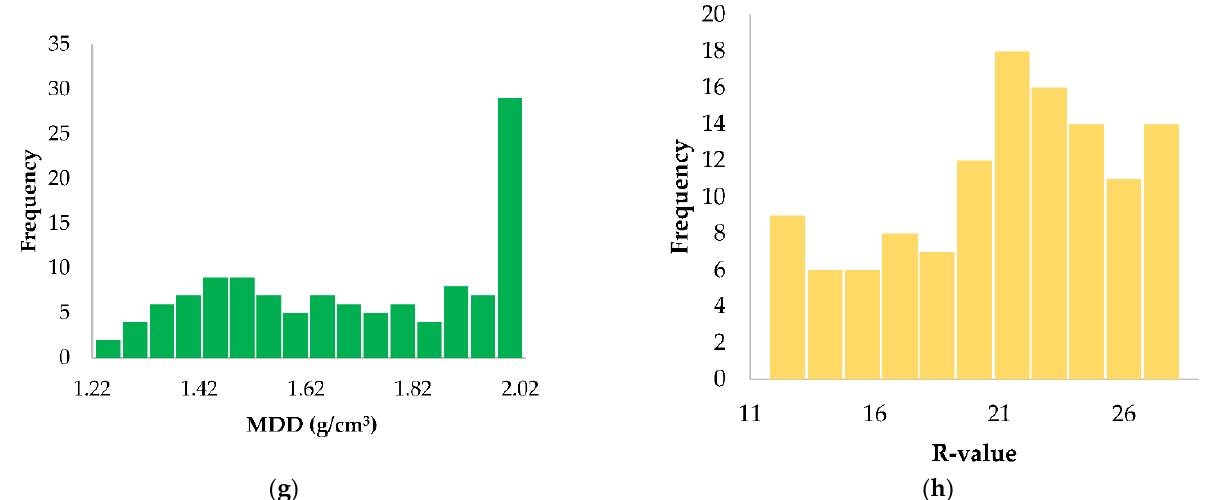
Figure 1. Histograms of the input (in green) and output (in yellow) variables used in this study. Table 1. Statistical analysis of the input and output parameters.